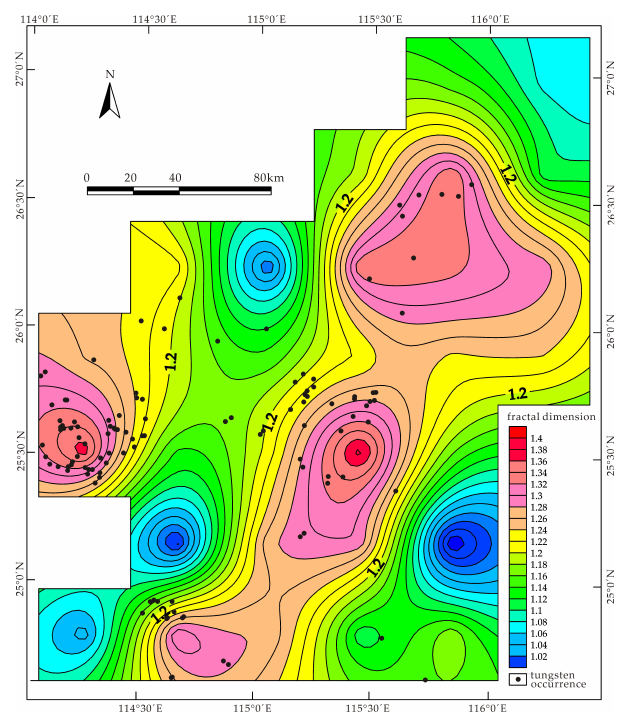
Figure 5. Contour map showing spatial distribution of fractal dimensions of regional faults.